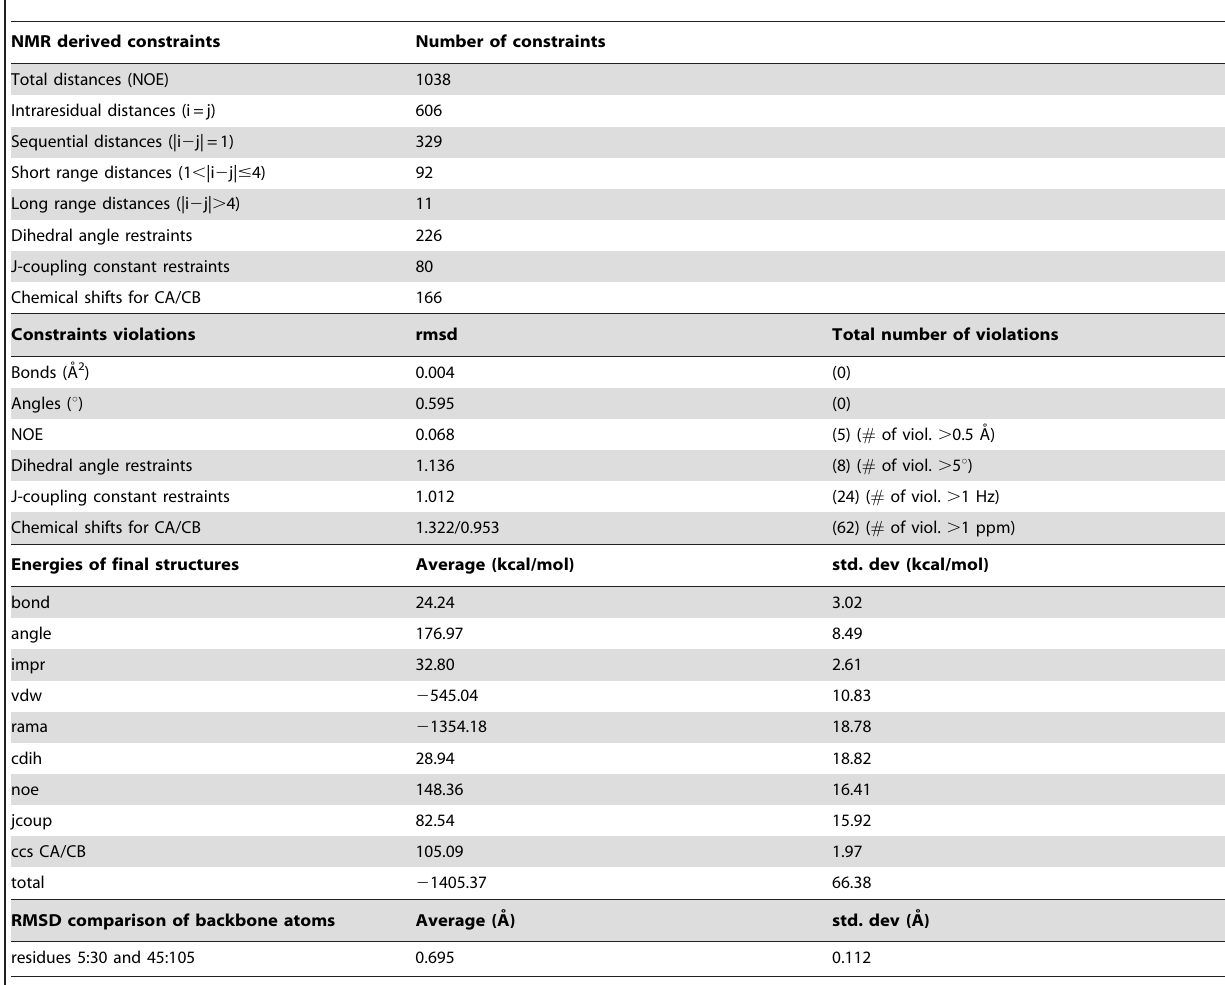
Table 1. Structural statistics of the 12 lowest energy